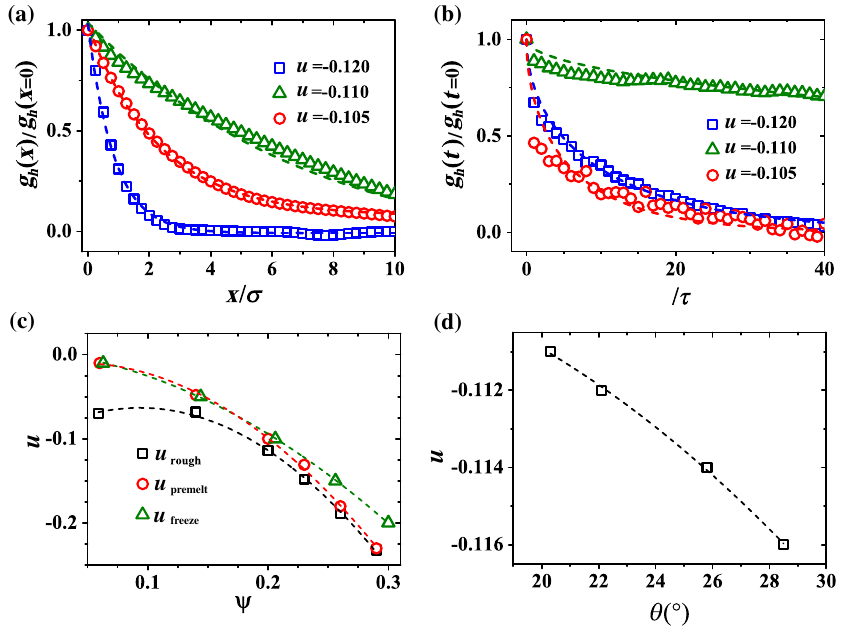
FIG. 12. Simulation results of the grain boundary with mismatch angle θ ¼ 25 . 8 °, and initial inclination angles α 1 ¼ 30 ° and α 4 . 2 ° at ψ ¼ 0 . 2 . (a) Spatial correlation functions and (b) time correlation functions at different effective temperatures u . Note that σ 2 ¼ represents particle diameter and τ represents time step [57]. (c) The phase diagram with the roughening, premelting, and freezing curves. (d) The roughening point u versus the mismatch R